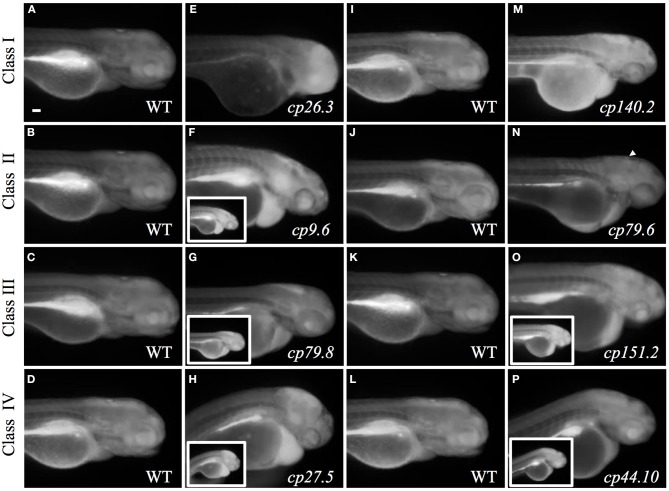
Fluorescein assay determines CP transport activity in mutants. (A–D) and (I–L) Wild-type larvae treated at 3 dpf with 50 μM fluorescein. (E)
cp26.3 mutant at 3 dpf. (F)
cp9.6 mutant at 3 dpf. Inset image is acquired at the same exposure to the corresponding wild-type in (B). (G)
cp79.8 mutant at 3 dpf. Inset image is acquired at the same exposure to the corresponding wild-type in (C). (H)
cp27.5 mutant at 3 dpf. Inset image is acquired at the same exposure to the corresponding wild-type in (D). (M)
cp140.2 mutant at 3 dpf. (N)
cp79.6 mutant at 3 dpf. Punctate accumulation of fluorescein in the brain ventricle is shown with an arrowhead. (O)
cp151.2 mutant at 3 dpf. Inset image is acquired at the same exposure to the corresponding wild-type in (K). (P)
cp44.10 mutant at 3 dpf. Inset image is acquired at the same exposure to the corresponding wild-type in (L). The larger images for (F,G,H,O,P) were taken at a lower exposure compared to the corresponding wild-type in order to visualize where the fluorescein was concentrating throughout the larvae. Scale bar is 50 μm.